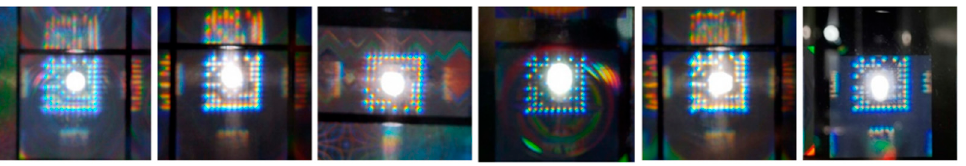
Figure 8. Restored optical coded mark with CGH using smartphone with LED flash.